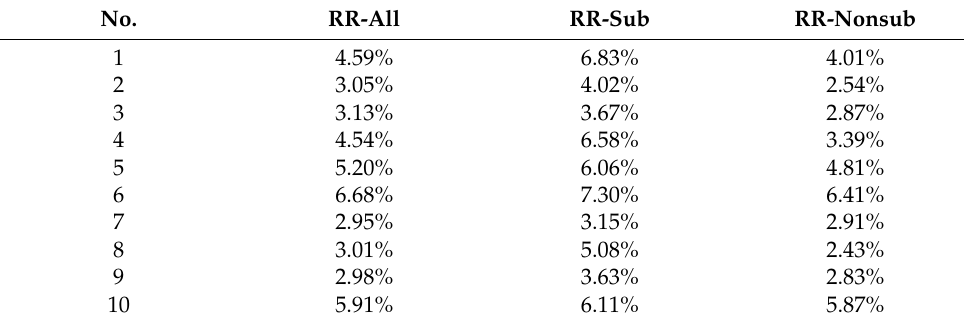
Figure 12. IV fitting curves for the third set of inputs: ( a ) I ds –V ds curves at different V gs when V bs = 0; ( b ) I ds –V gs curves at different V bs when V ds = 1.0 V. Table 4. Errors of ten sets of inputs.